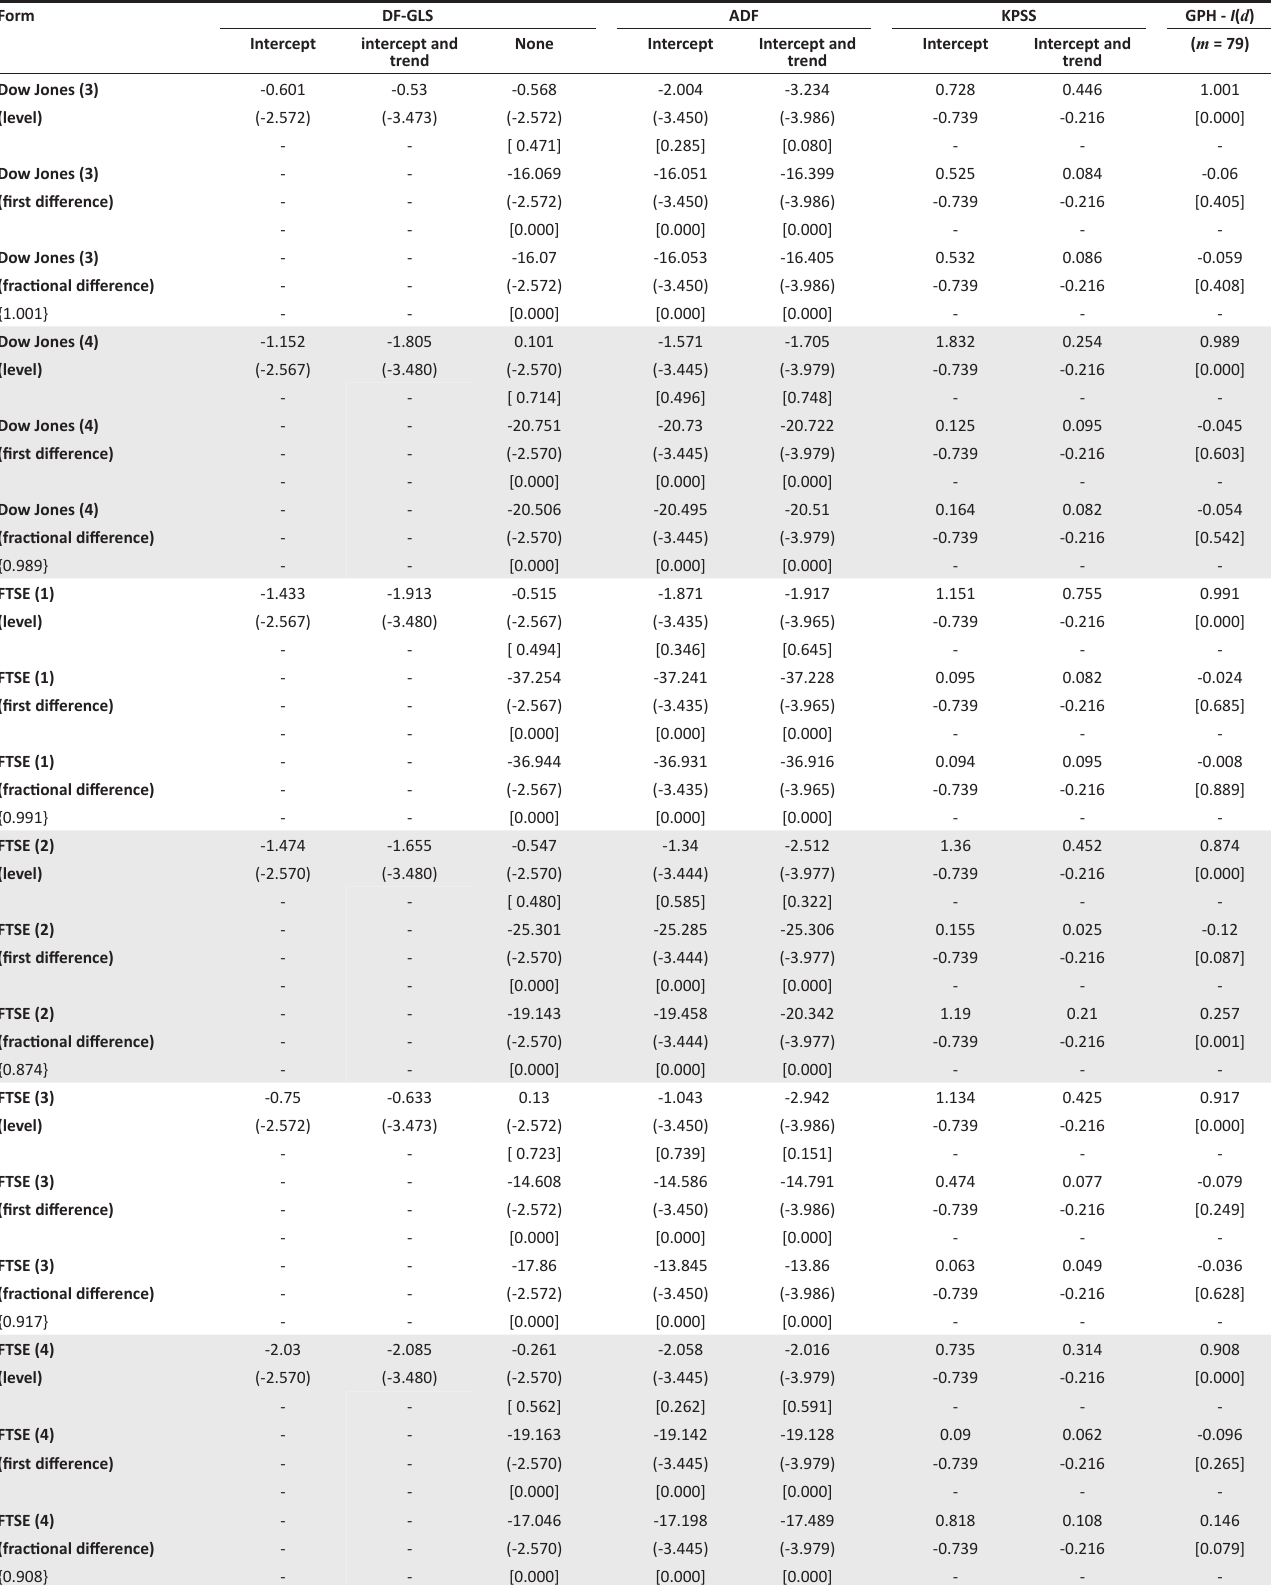
TABLE A1 (Continues...): Determining the correct form of